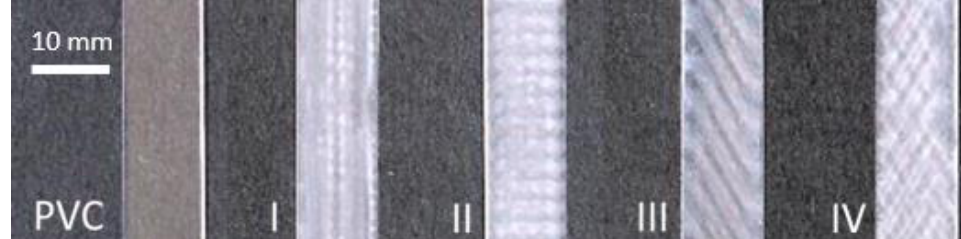
Figure 3. Investigated PVC polymer films: Without DCSBD plasma modification (PVC); Exposed to DCSBD plasma modification (I, II, III and IV). Characteristic bands are due to electrode wending in ceramic dielectric. Top view.